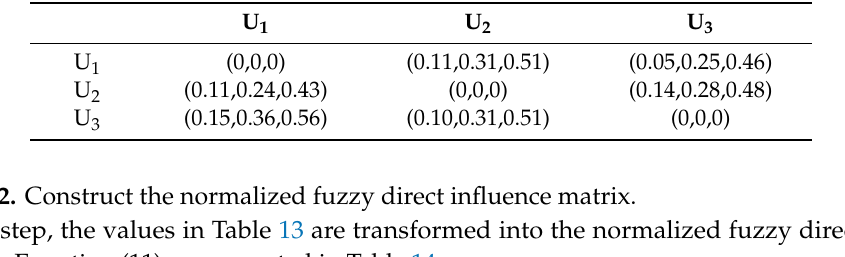
Table 13. The fuzzy direct influence matrix.